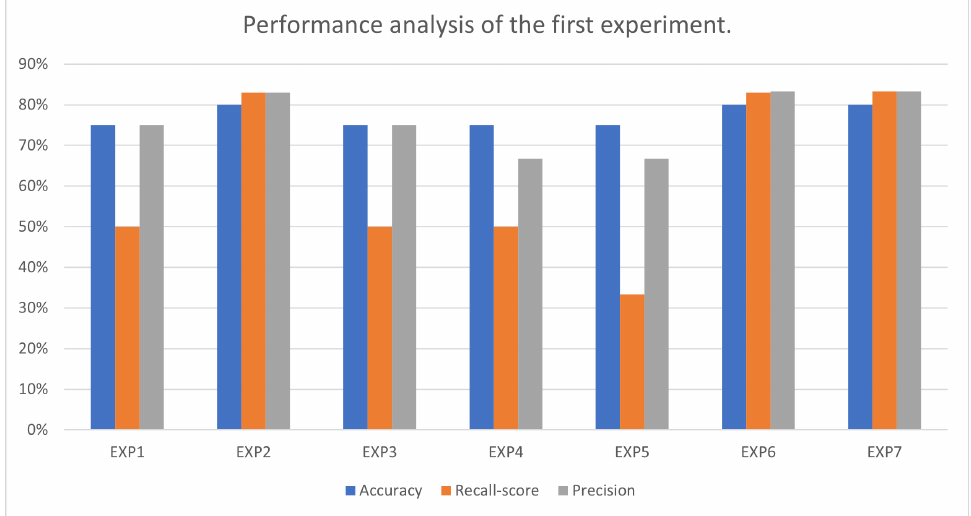
Figure 7. Accuracy, recall score, and precision of different combinations of measurements in the first experiment.